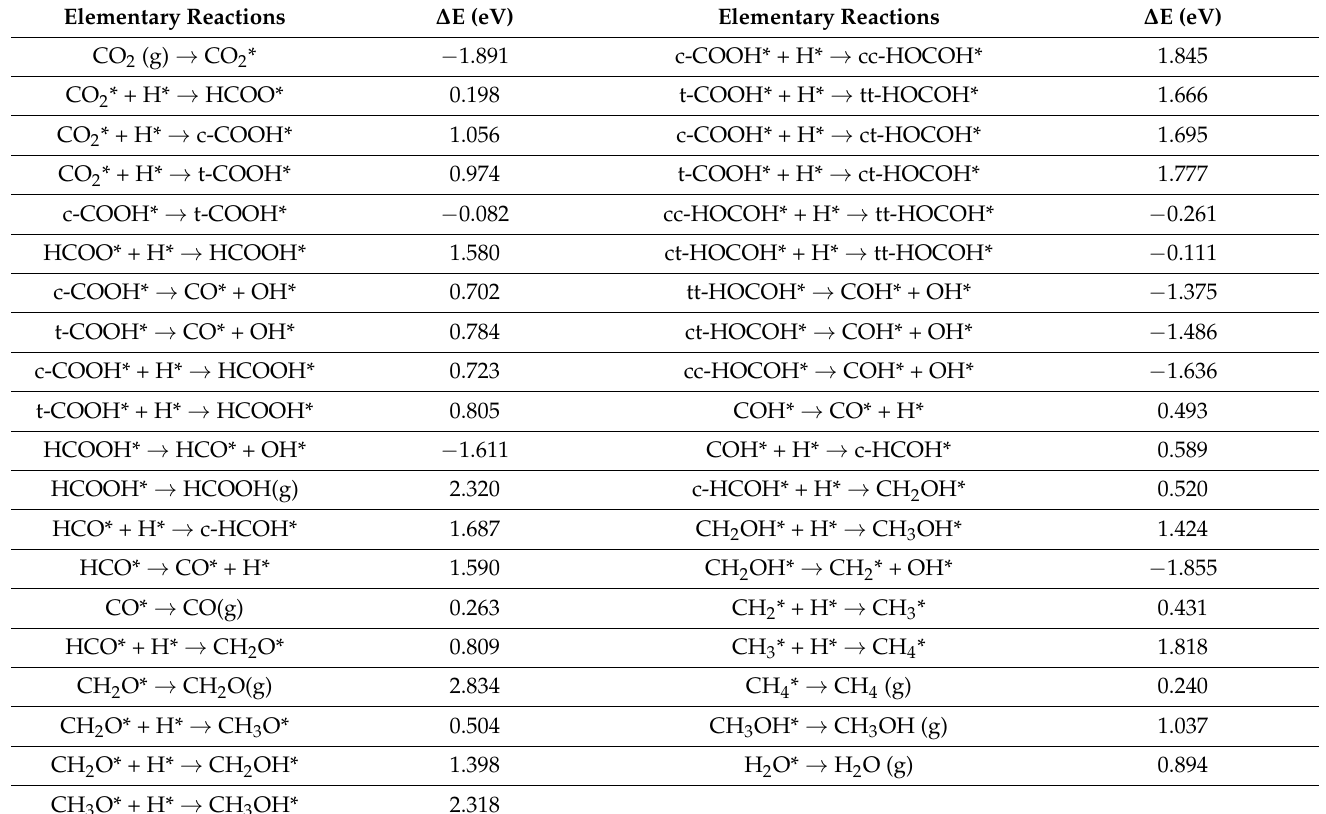
Table 2. The possible reactions and their corresponding energies in the hydrogenation of inter- mediates to form CO, HCOOH, CH 2 O, CH 3 OH, and CH 4 . It should be noted that the adsorbed intermediates on the surface are indicated by the symbol